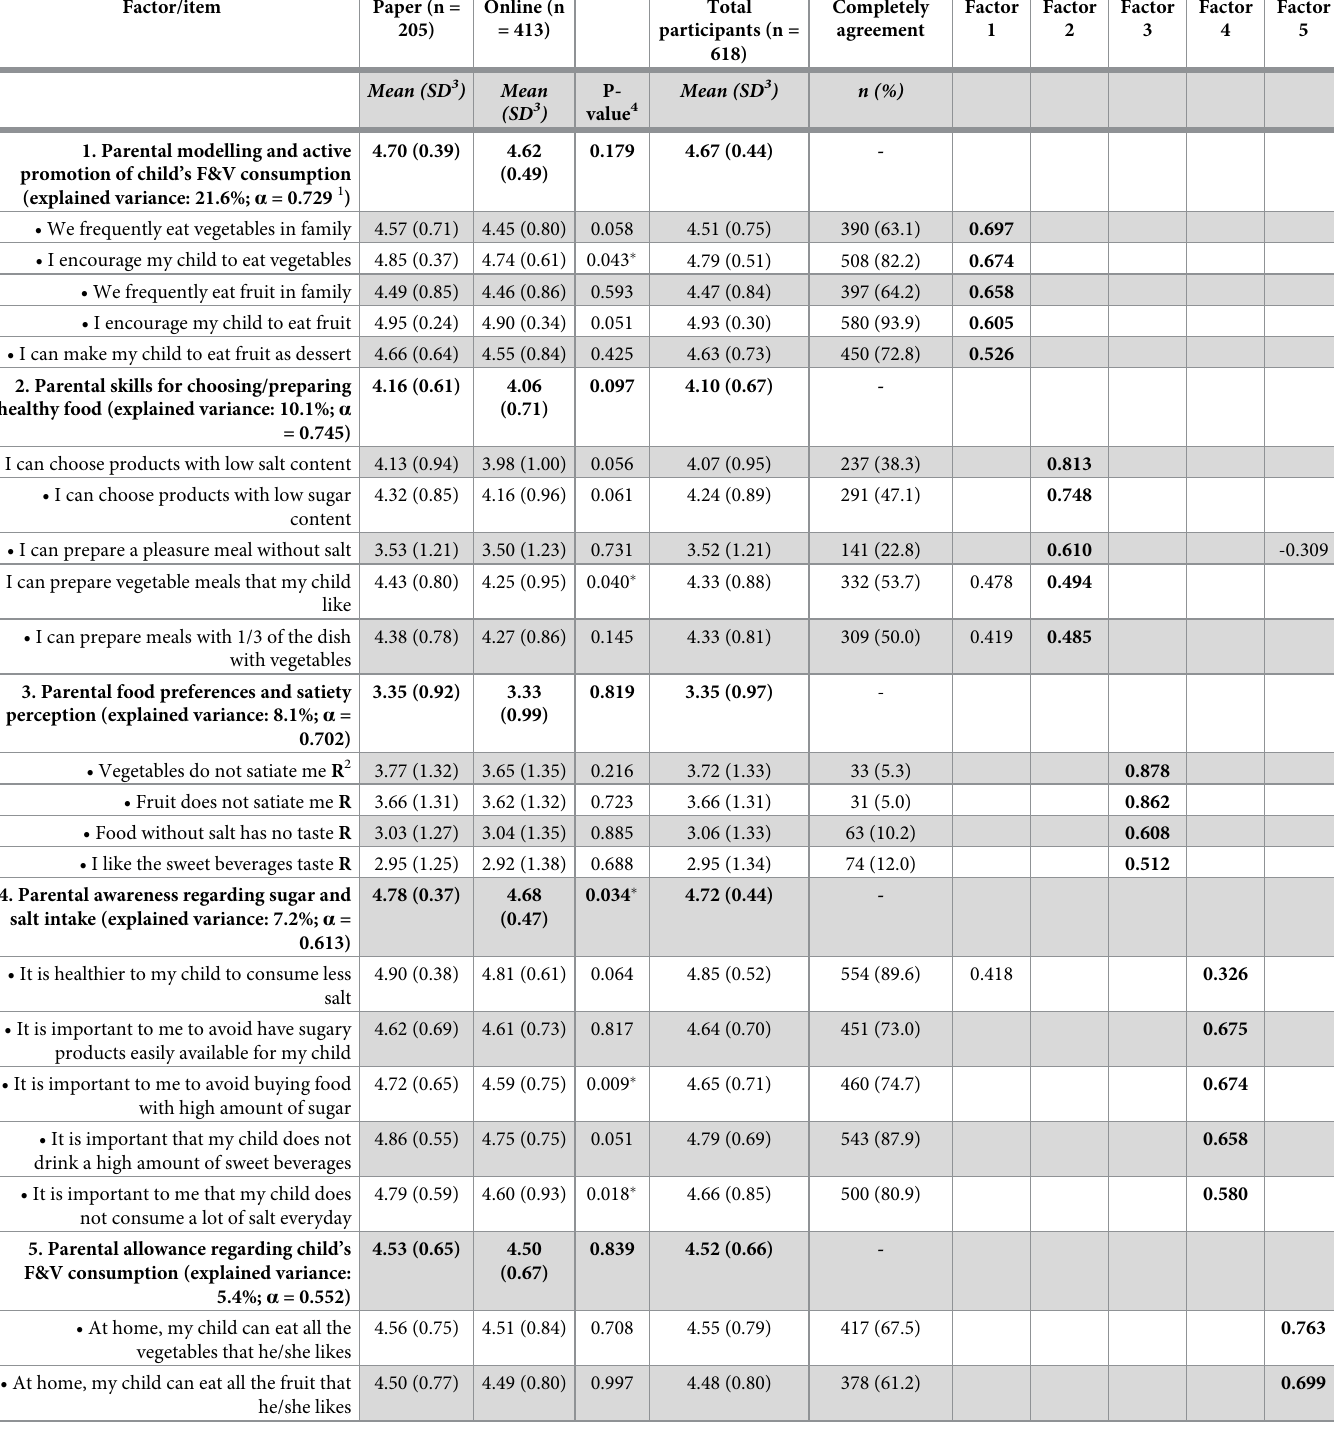
Table 2. Factors’ characterization, reliability and factorial loadings by Varimax rotation (5 factors extracted) (N = 618).